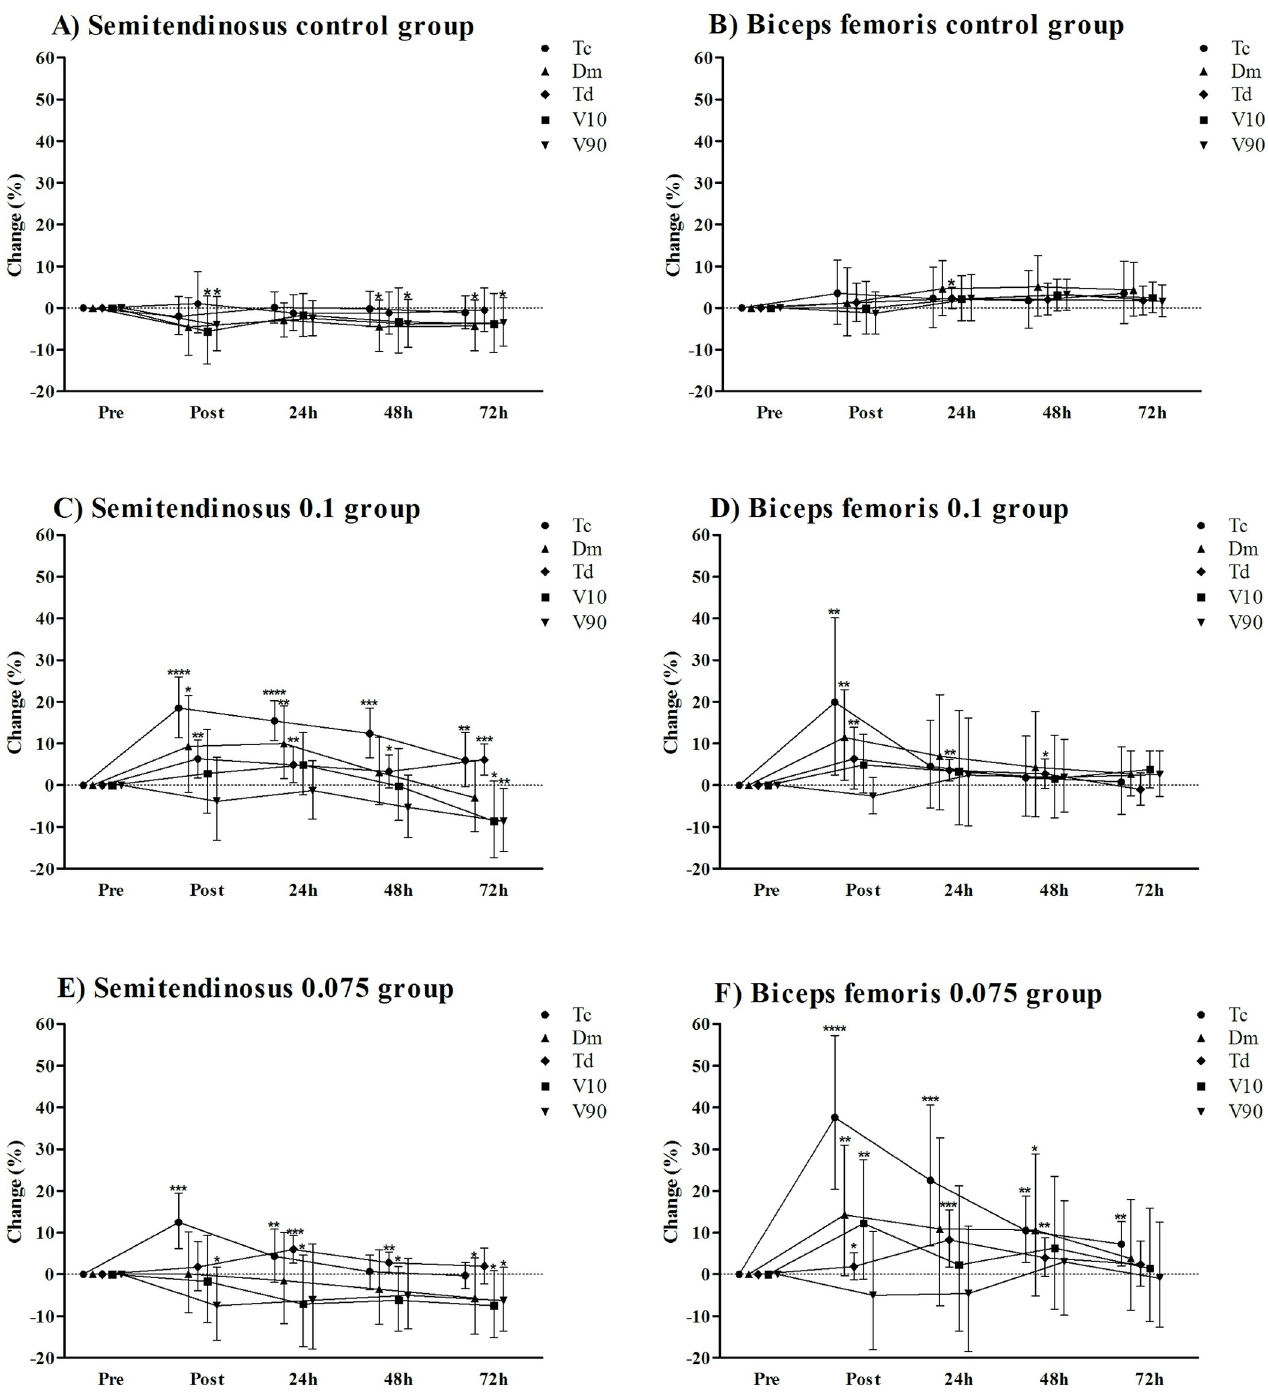
Fig 4. Muscle contractile properties changes immediately, 24h, 48h and 72h after control condition and iso-inertial exercise. Panel A: semitendinosus muscle of the control group; Panel B: biceps femoris muscle of the control group; Panel C: semitendinosus muscle of the 0.01 group; Panel D: biceps femoris muscle of the 0.1 group; Panel E: semitendinosus muscle of the 0.075 group; Panel F: biceps femoris muscle of the 0.075 group. Data are mean and 90% confidence interval. Tc: contraction time; Dm: maximal radial displacement of the muscle belly; Td: delay time; V 10 : muscle contraction velocity at 10% Dm; V 90 : muscle contraction velocity at 90% Dm. ���� almost certainly, ��� very likely, �� likely, � possibly differences in relation to baseline (pre) measurement.